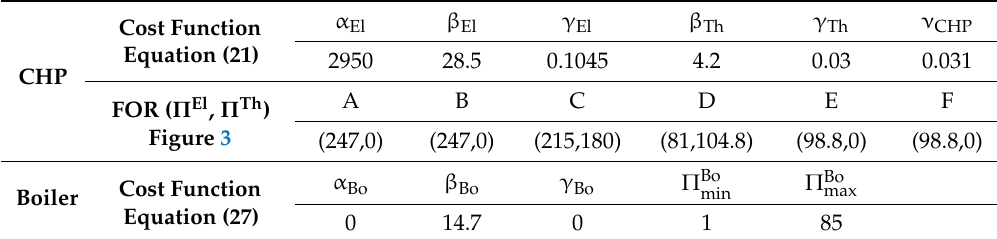
Table 2. Technical data of CHP and industrial boiler.